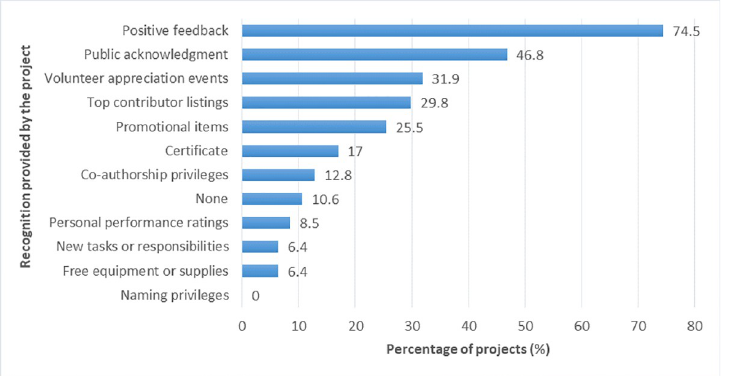
Fig 12. Forms of recognition or rewards provided by the projects.